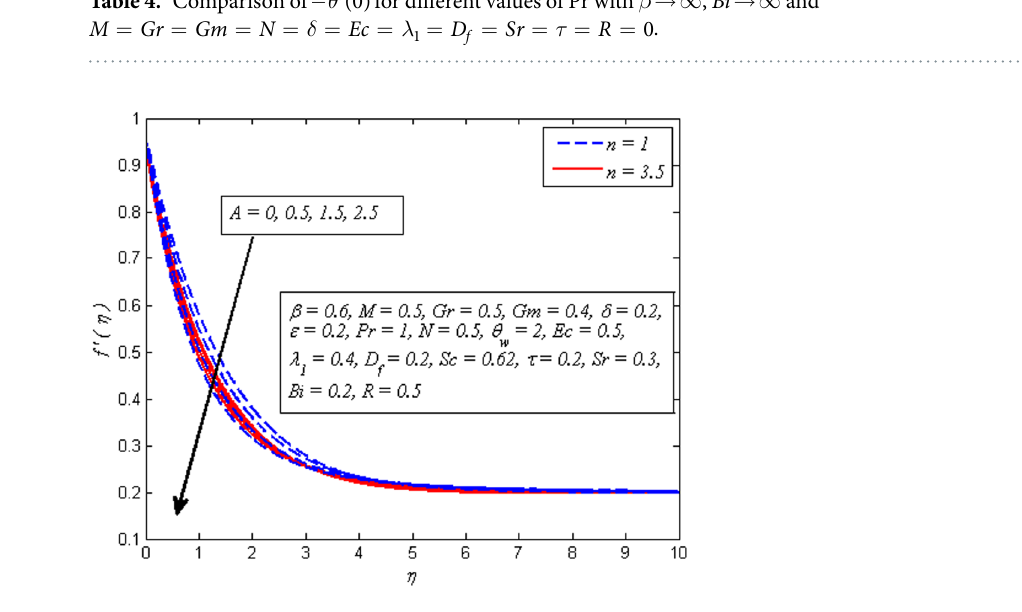
Figure 2. Effect of A on velocity for two different values of n